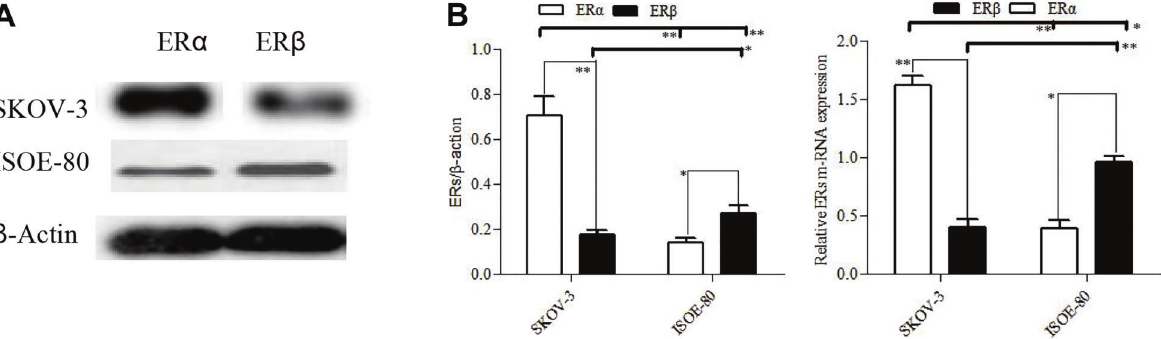
Figure 2. Estrogen receptor (ER) a and ER b were conversely expressed in SKOV-3 human ovarian cancer cells and ISOE-80 human normal cancer cells. A , sema 4D protein expression by western blotting. B , Semaphorin 4D (sema 4D) m-RNA expression by RT PCR. b -actin was used as the internal standard. Data are reported as means ± SD. (*P o 0.05, **P o 0.01,